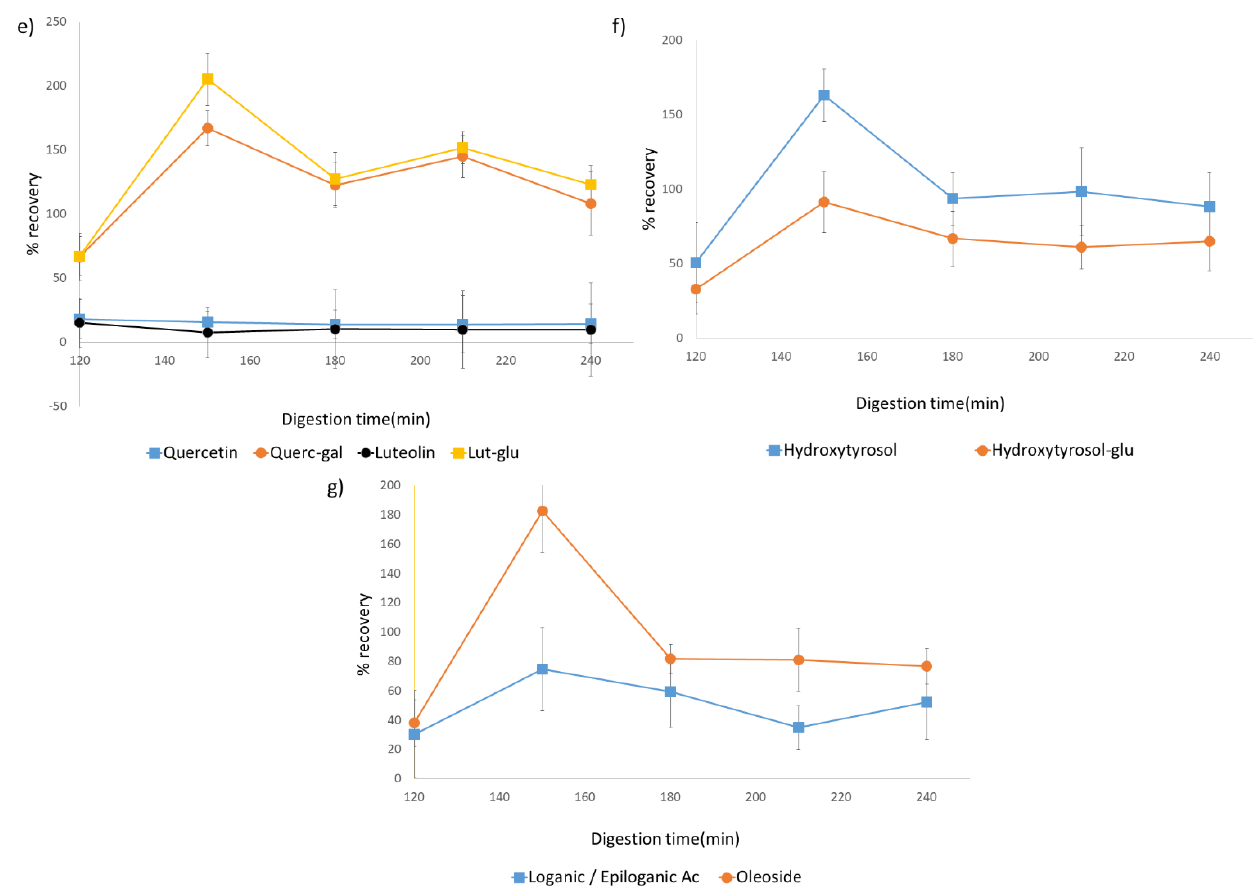
Figure 2. Accumulative recovery (%) of polyphenols during in vitro gastrointestinal digestion: ( a ) oleuropein aglycone, oleuropein diglucoside, and 10-hydroxyoleuropein aglycone; ( b ) hydroxyl- oleuropein and metoxyoleuropein; ( c ) oleuropein and isomers 1 and 2; ( d ) ligstroside and elenolic acid; ( e ) quercetin, quercetin-galactoside, luteolin, and luteolin-glucoside; ( f ) hydroxytyrosol and hydroxytyrosol glucoside; ( g ) loganic/epiloganic acid and oleoside.